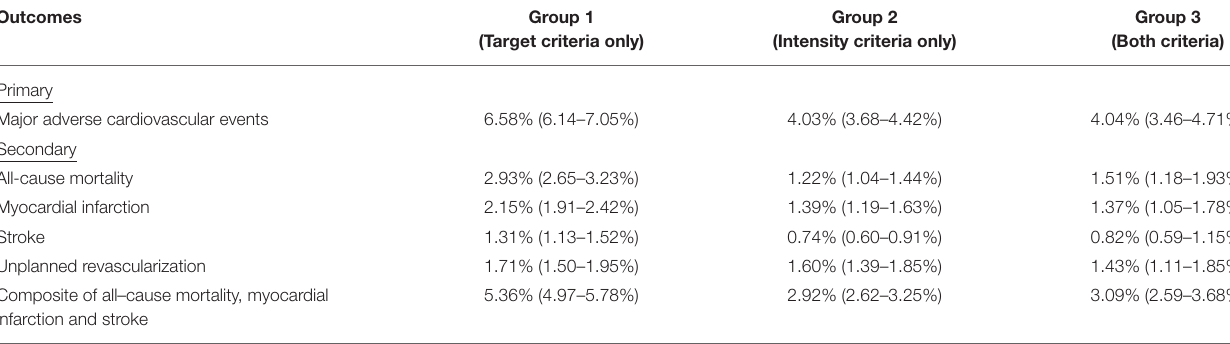
TABLE 3 | Unadjusted annualized risks (95% confidence interval) of primary and secondary outcomes.